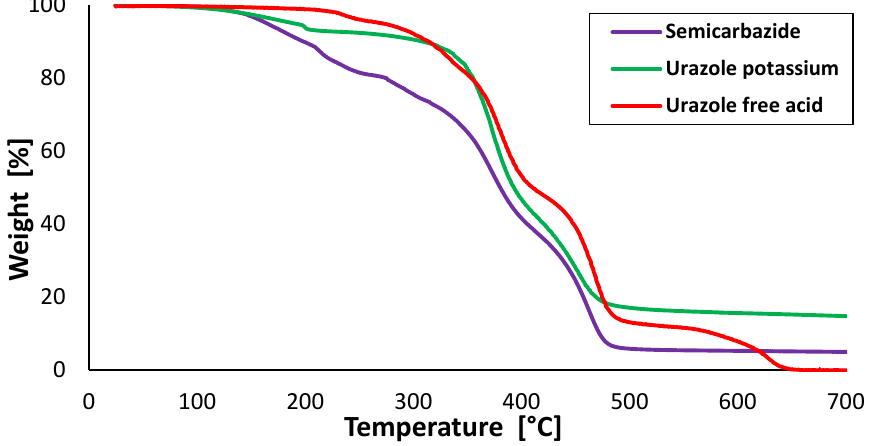
Figure 4. Thermogravimetric analysis of semicarbazide gel, urazole-potassium hydrogel and urazole-free acid gel.